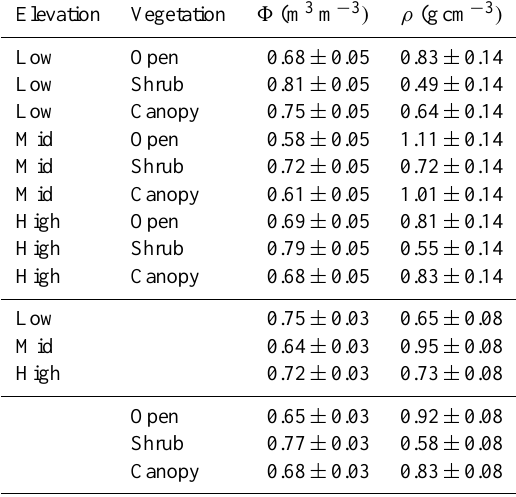
Table E1. Least-squares means of soil porosity ( (cid:56)) and soil bulk density ( ρ) for the 0–12cm soil depth used in calculating